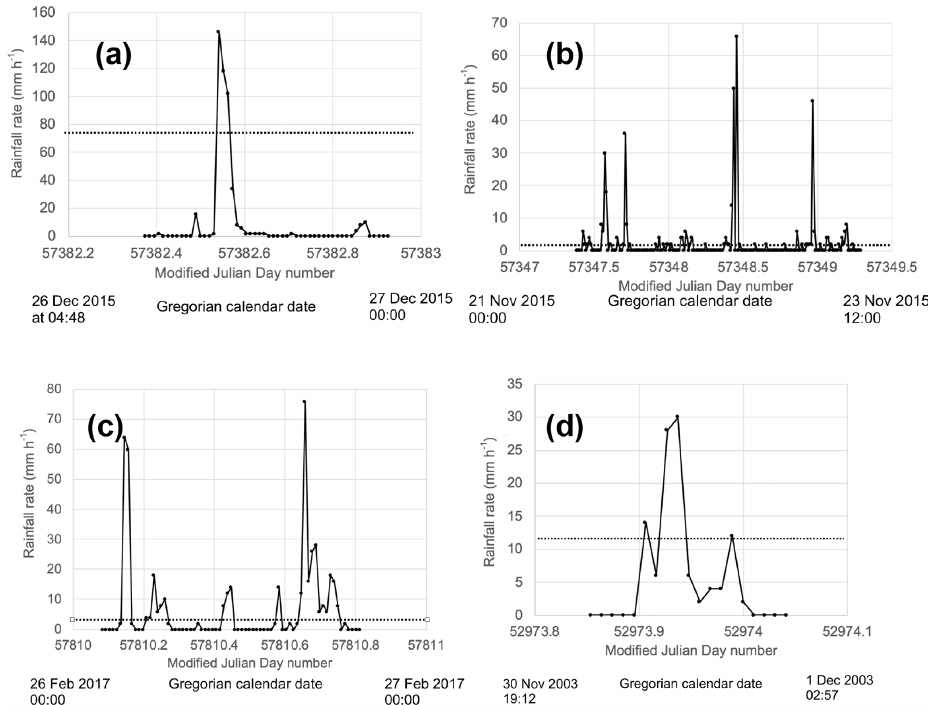
Figure 1. Examples of intensity bursts in rainfall records from the field sites, shown using data aggregated to 15min totals. Each dot represents a 15min period. Field locations: (a–c) MM and (d) FG. The four intensity plots shown here each show the entirety of a rainfall event defined using MIT = 6h (refer to text for details). Each event begins with the first rainfall and ends with the last rainfall; preceding and subsequent observations showing zero rainfall rate are not included in the events. Event (a) is mostly rainless but includes a single very intense burst; events (b) and (c) contain one or more bursts together with periods of lower intensity; event (d) shows continuous rainfall with a central intensity burst. In each case the dotted lines indicate the average intensity of the rainfall